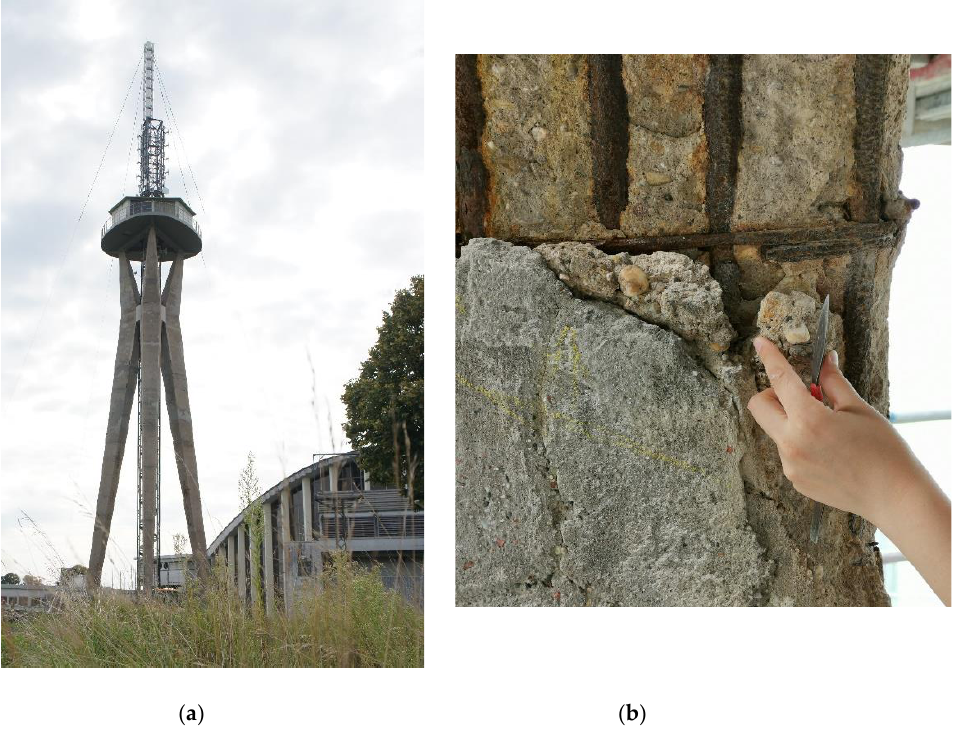
Figure 5. Europe 1 broadcasting center tower: ( a ) general view (© Franziska Braun); ( b ) a typical damage pattern (© Melanie Groh).